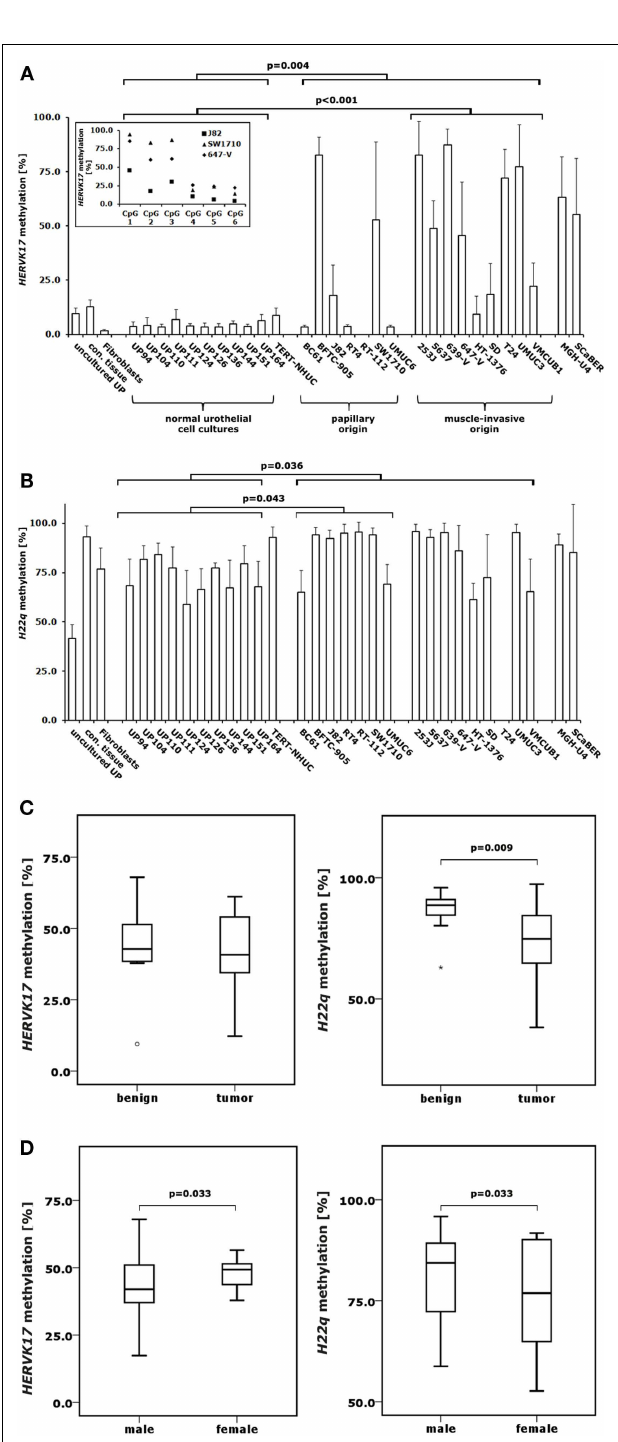
FIGURE 3 | DNA methylation changes in proviral HERVK17 and H22q LTRs in bladder cancer . DNA methylation in the LTRs of HERVK17 (A) and H22q (B) were analyzed by pyrosequencing in 10 normal urothelial cell cultures and 18 bladder cancer cell lines. Additionally, HERVK17 and H22q DNA methylation was assessed in immortalized urothelial cells (TERT-NHUC) and in uncultured epithelial cells (uncultured UP) and connective tissue from one ureter. (C) DNA methylation of HERVK17